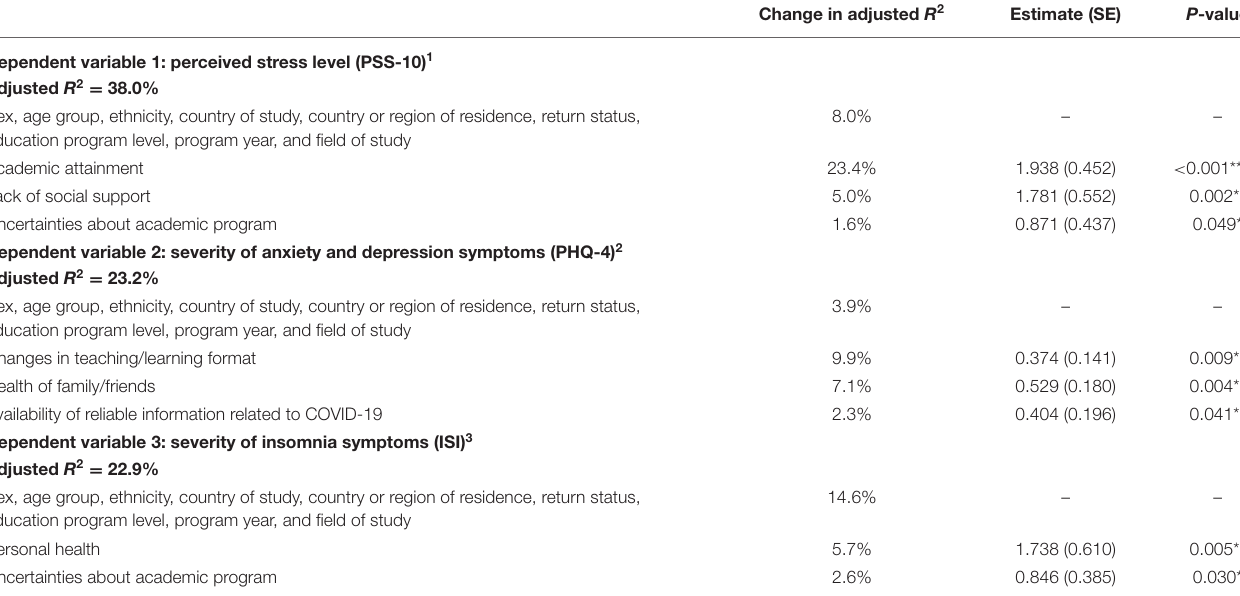
TABLE 5 | Coronavirus disease 2019 (COVID-19)-related stressors as predictors of mental health impacts identified by forward stepwise multiple regression analysis ( n = 124).